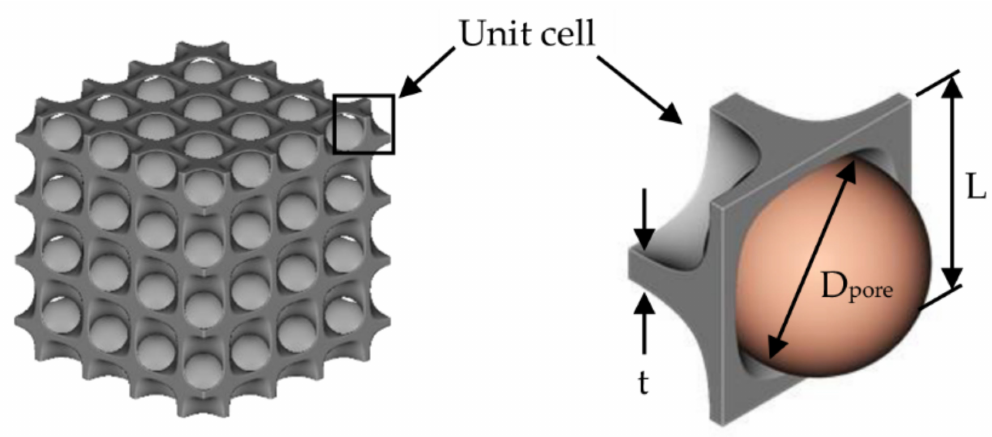
Figure 6. An example of parameters of TPMS generation.